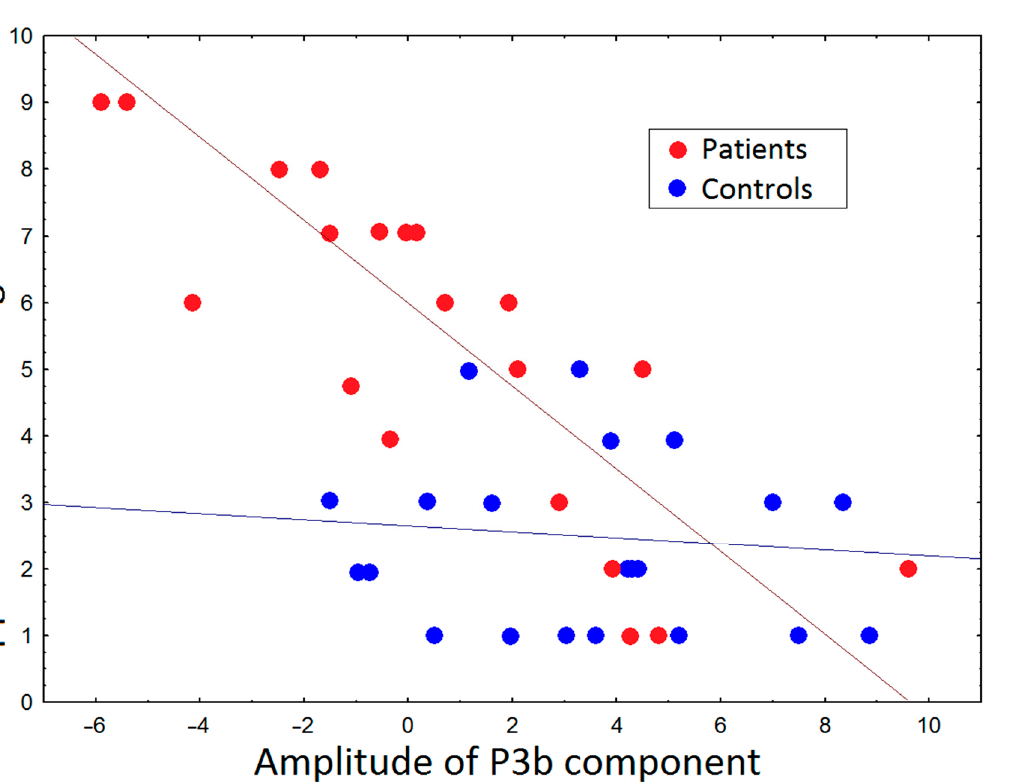
Figure 4. Scatter–plot of individual values demonstrated significant correlation between the am- plitude of P3b component for “happiness” of non–congruent stimuli in group of patients and healthy